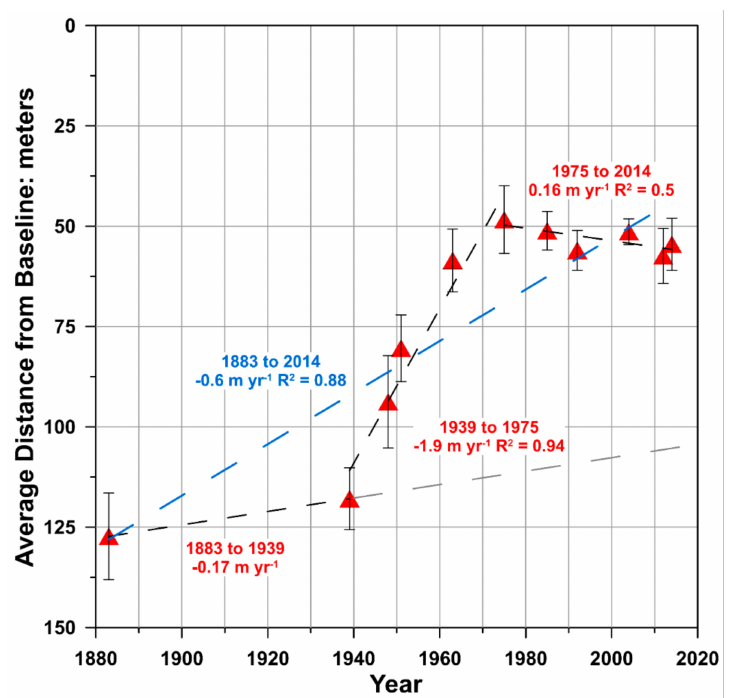
Figure 7. Average position of the southern shoreline of Napatree Barrier 1883–2014 expressed as distance from the onshore baseline. Triangles show the average position of the barrier (transects 20 to 50). Error bars are based on the standard deviation in distance from the baseline for that shoreline reported in Table 4. The dashed blue line represents a linear best fit through the average positions (1883–2014). The dashed gray line represents the continuation of the 1883–1939